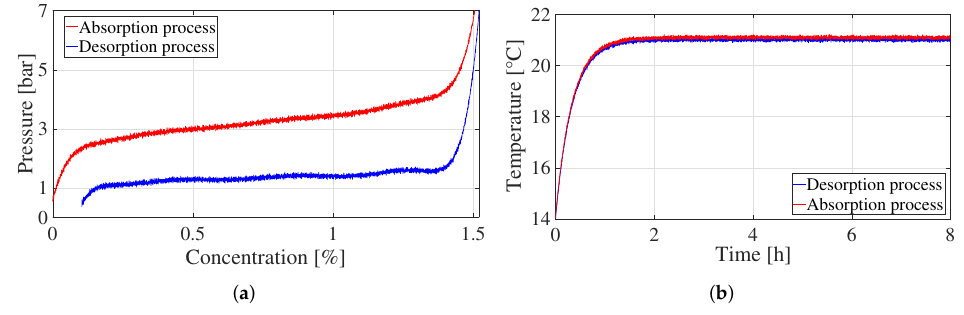
The hydrogen supplied/extracted during the two states studied (healthy, degraded) has a constant flow rate of 4 NL/min, at a pressure of 7 bar and a purity of 99.99%. Figure 6a,b present the experimental values of pressure as a function of concentration and temperature versus time, respectively, for a metal hydride tank in its healthy state [38].